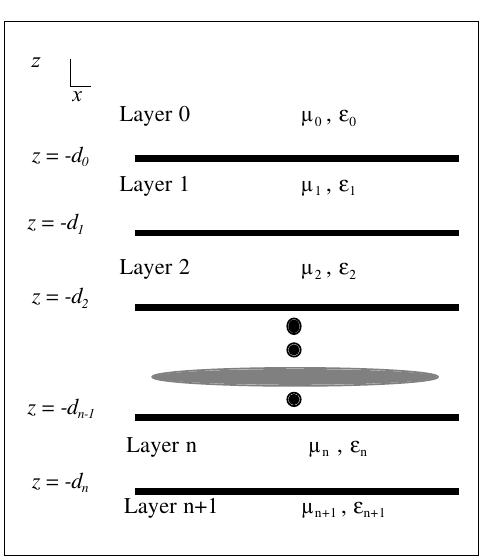
Fig. 4. Subsurface